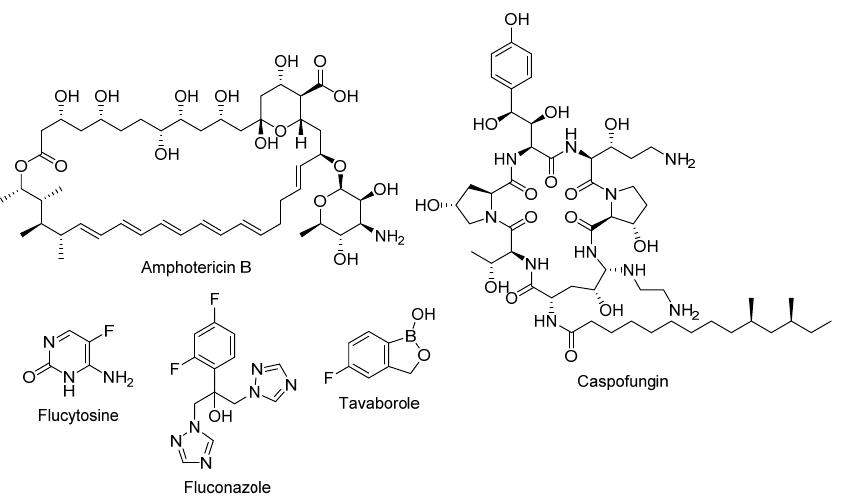
Figure 2. The chemical structures of amphotericin B (an example of a polyene); caspofungin (an ex-